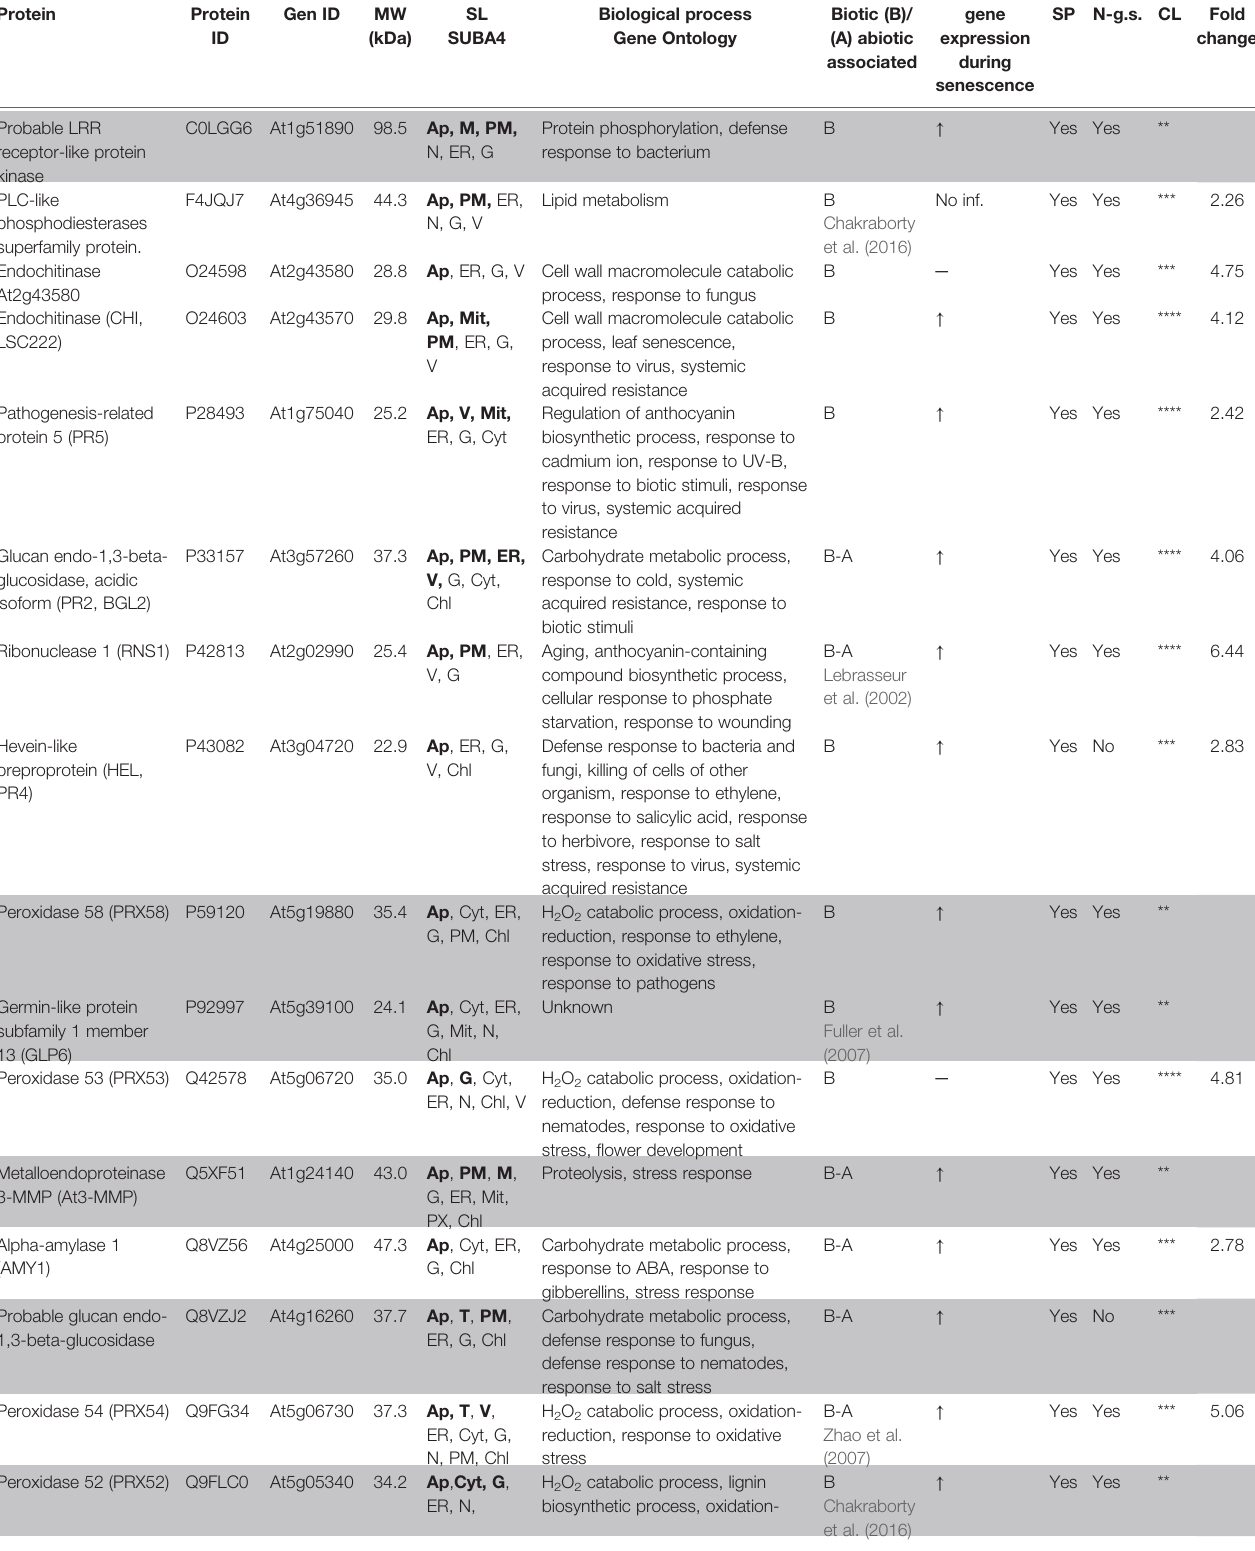
TABLE 3 | AF proteins with two fold increased levels during leaf senescence.